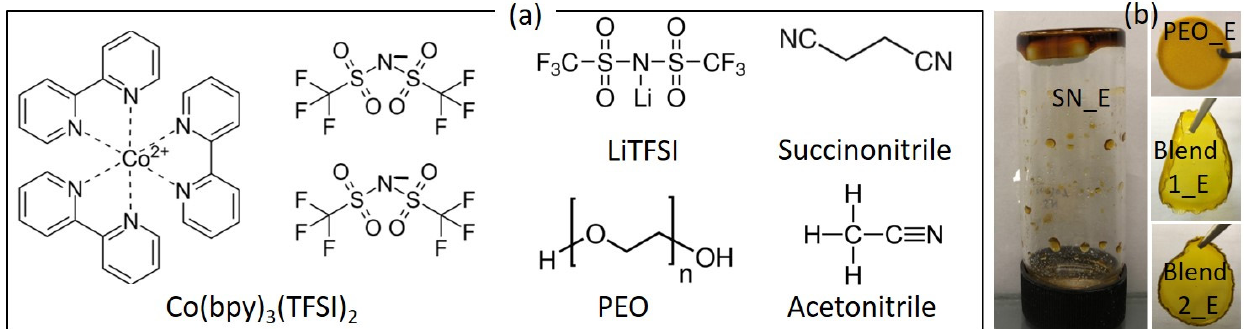
Figure 1. ( a ) Chemical structure of ingredients. ( b ) Optical image of solid redox mediators.